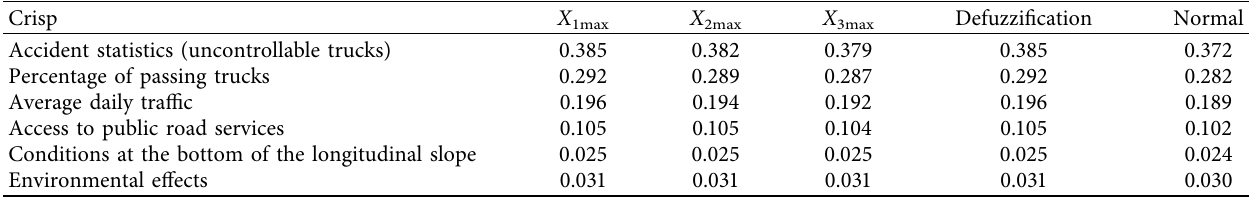
Table 10: Defuzzification and determination of the definite weight of other factor